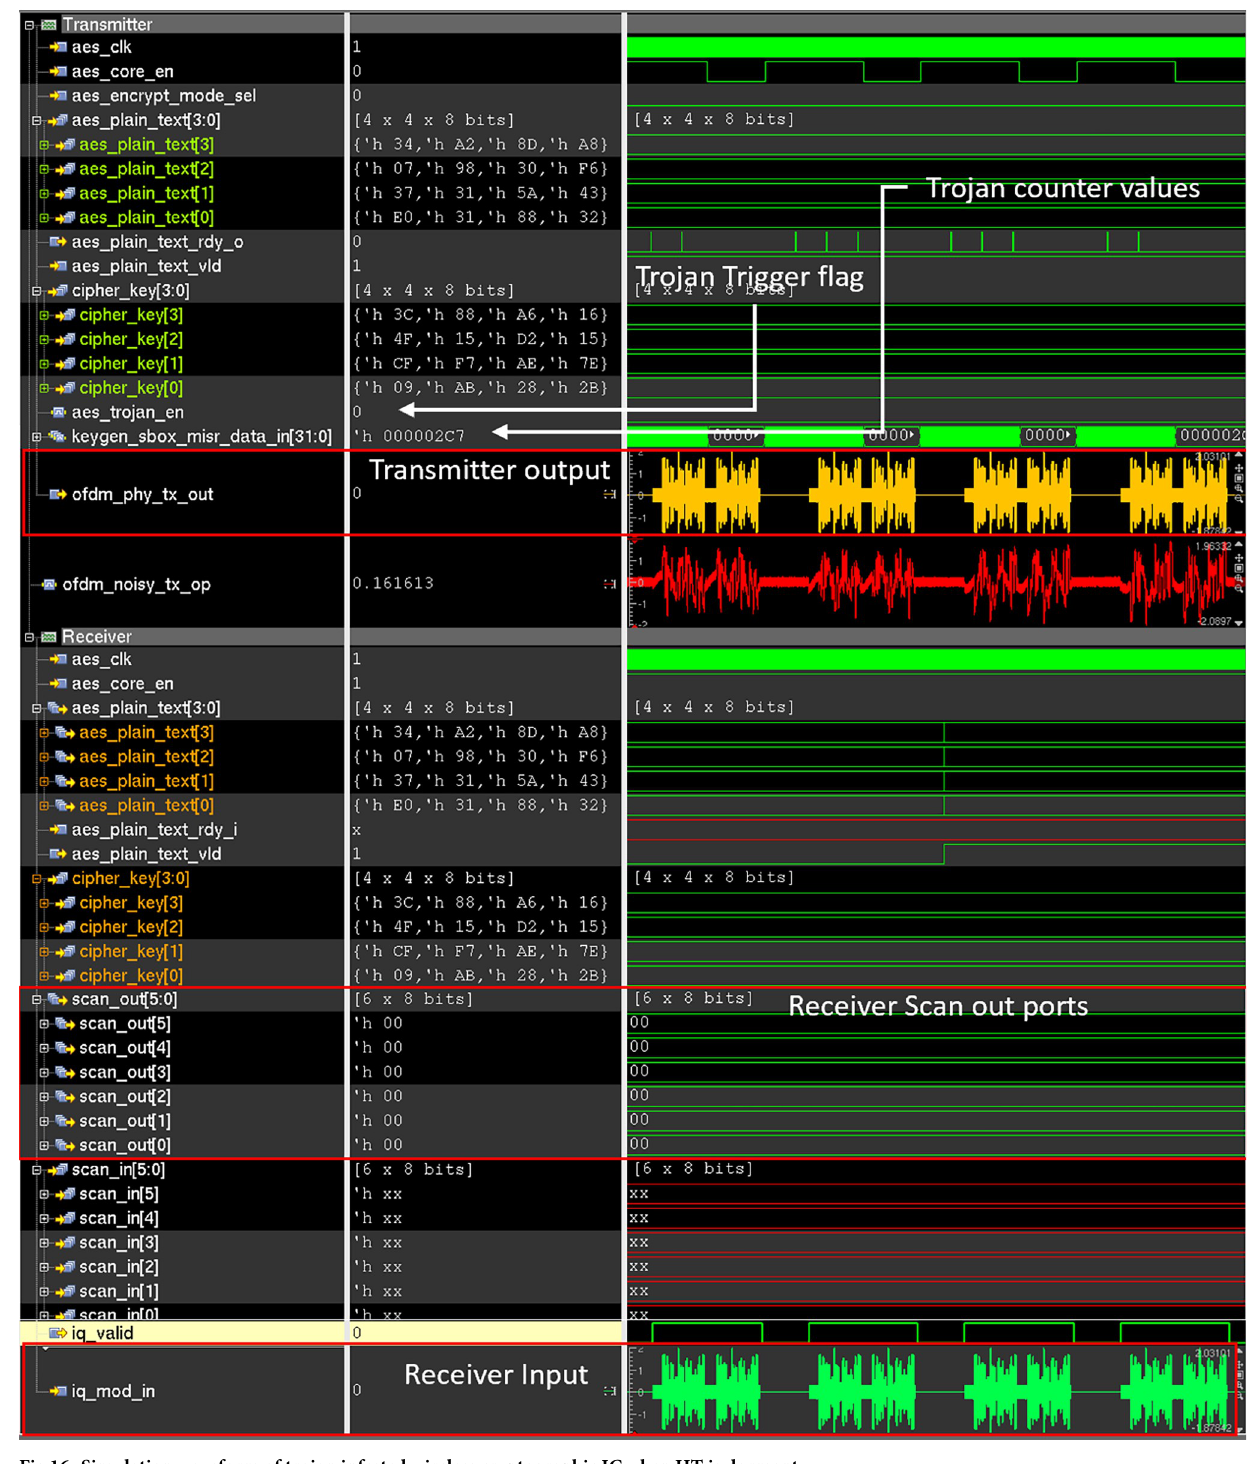
Fig 16. Simulation waveform of trojan infested wireless cryptographic IC when HT is dormant.